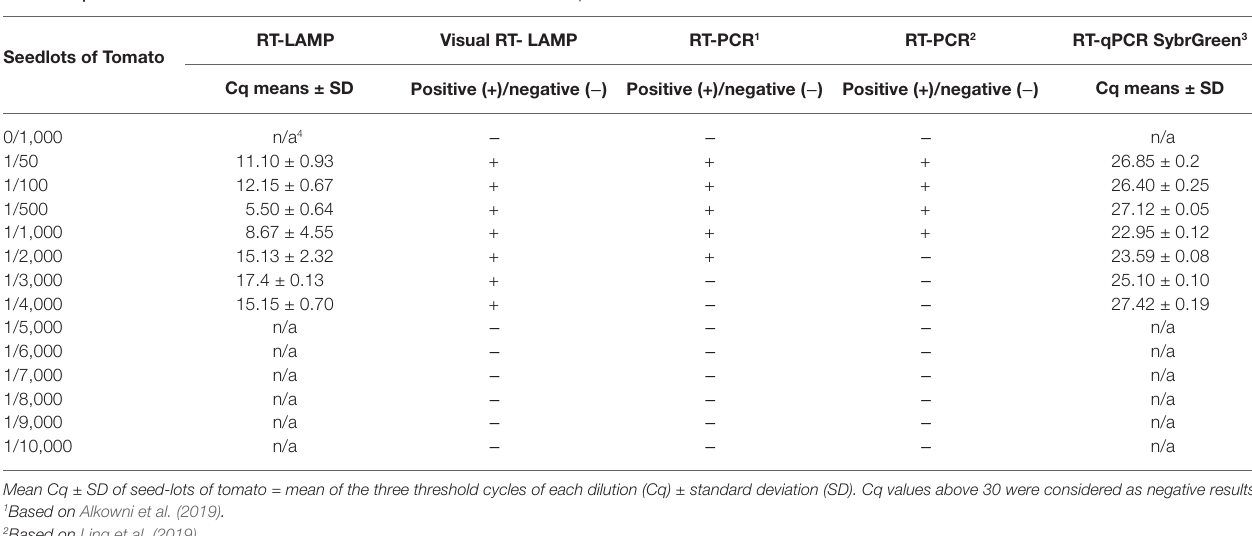
TABLE 4 | Detection of ToBRFV in seed-lots of tomato with different techniques.